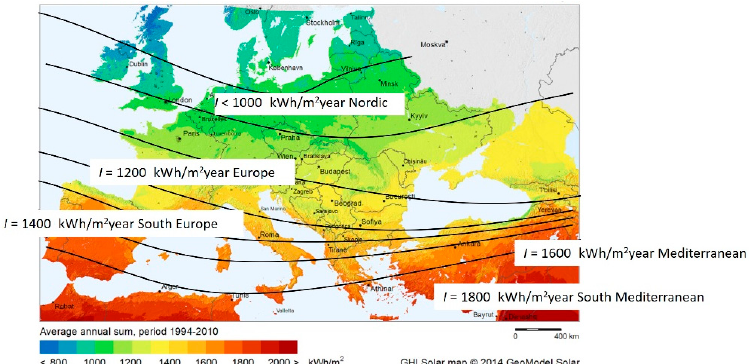
Figure 6. Solar PVT Feasibility Map for Different Levels of Solar Irradiation in Europe.